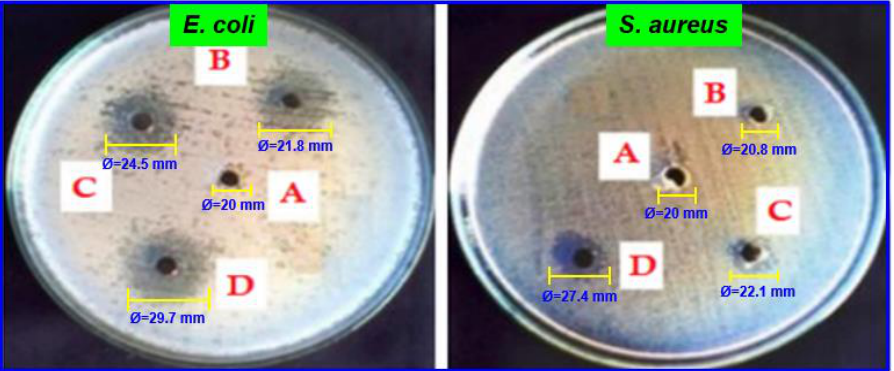
Figure 9. Antimicrobial activity: images depicting ( A ) chitosan film, CSA composites with ( B ) 10.0 ( C ) 30.0 and ( D ) 50.0 wt. % of almond gum.